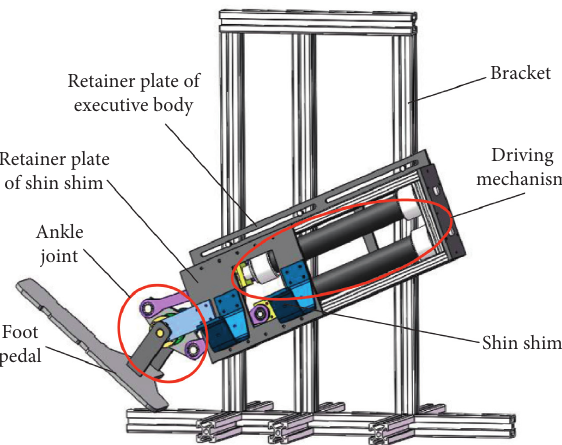
Figure 1: CAD model of the ankle rehabilitation